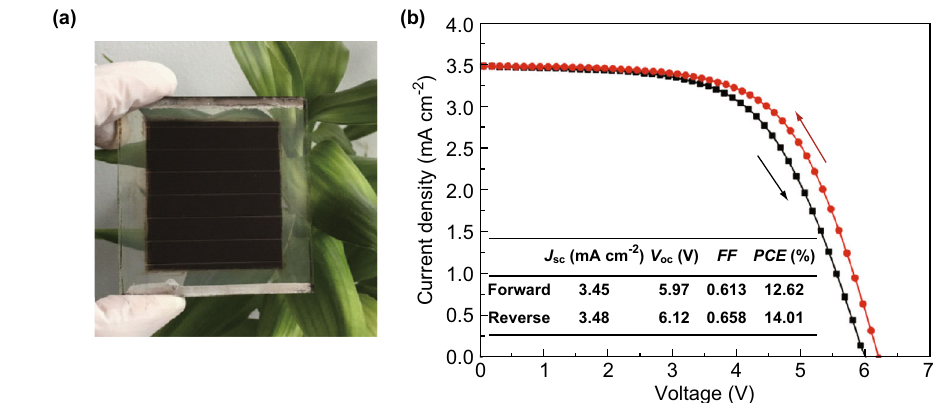
Fig. 6 a Photograph of the backside of the perovskite module consisting of 6 sub-cells with a total aperture area of 16 cm 2 . b J – V curves of the solar module measured in forward and reverse modes under a simulated solar light of AM 1.5 G and 100 mW cm -